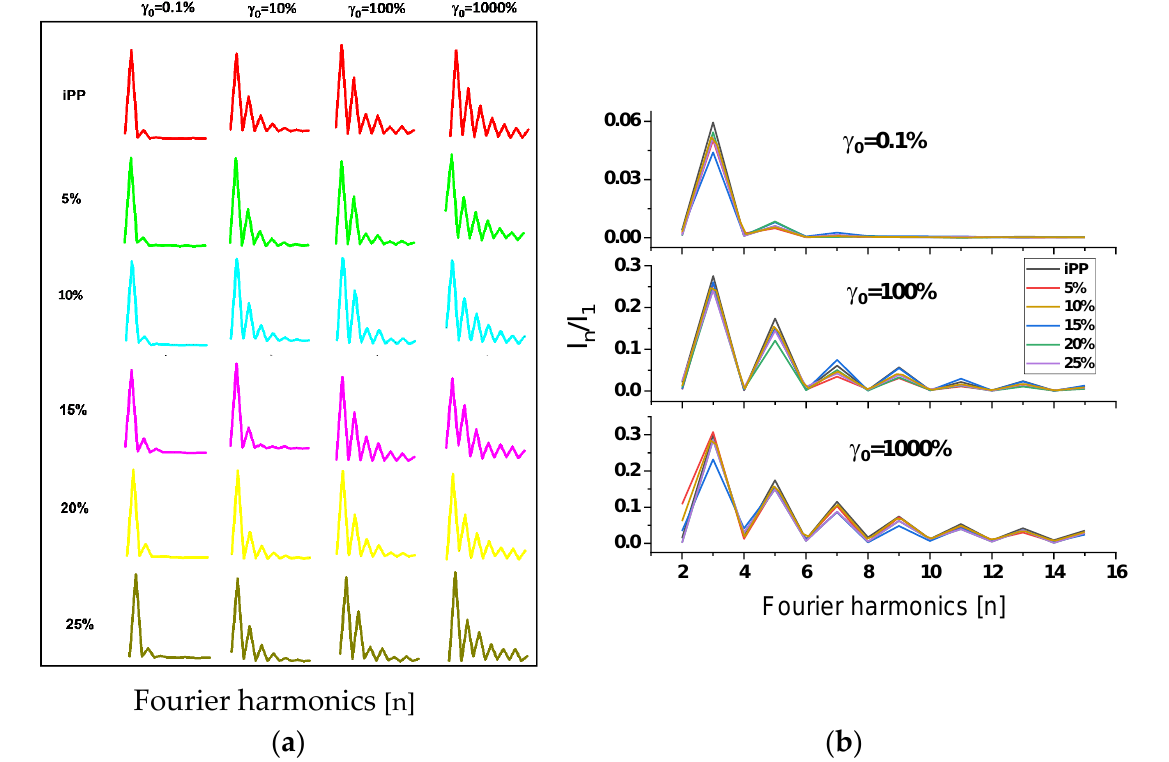
Figure 6. Fourier spectra at different dynamic strains (γ 0 ) for pure iPP, LMPP and blends at 1.0 rad s −1 ( a ), ( b ) showing comparative intensities of blends at given γ 0 . Under LAOS stresses, the blends demonstrated subtle large-strain elastic modulus ( G L ) and large strain-rate dynamic viscosity ( η L ), while minimum-strain elastic modulus